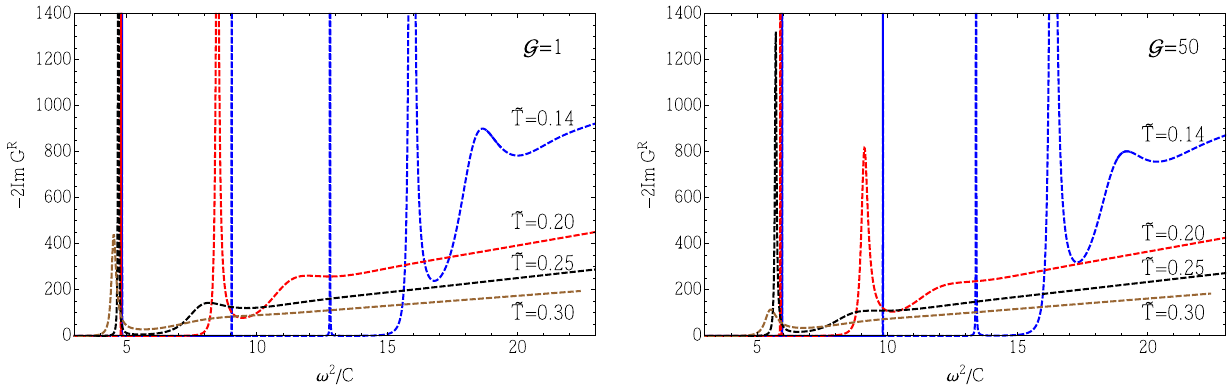
Fig. 6 Spectral functions with zero wavenumber in the low-temperature regime for G = 1 (left panel) and G = 50 (right panel). The number of peaks decreases with the temperature in both cases